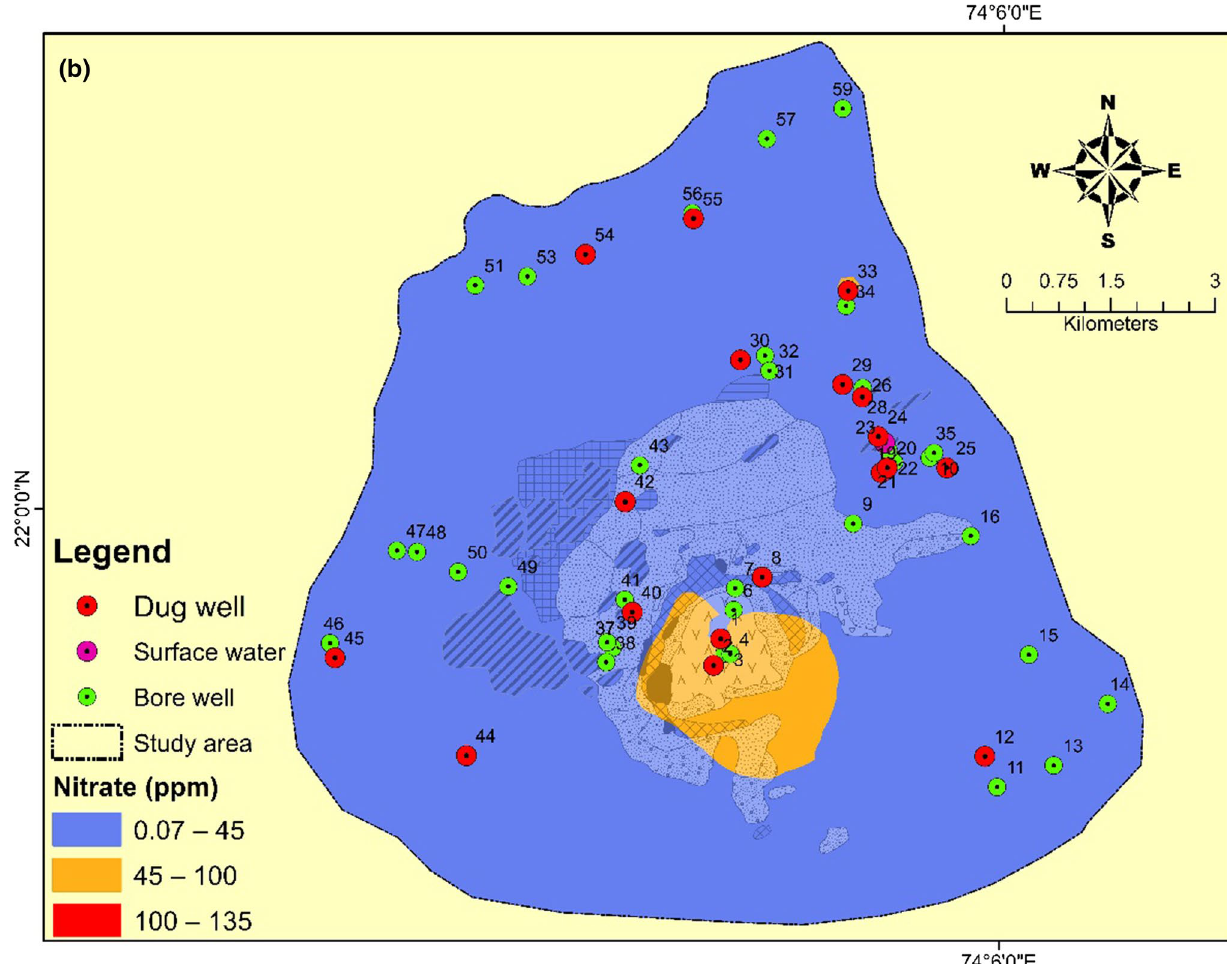
Piper plot: To categorise and differentiate the ground- water on the basis of its chemical composition the Piper’s trilinear diagram was used (Piper 1953) (Fig. 6a, b). This is helpful to know the total element character of waters in terms of cations and anions composition. The Piper’s plot for POM (Fig. 5a) shows that the Ca 2+ and HCO 3− as the main cations and anions, respectively. Most of the samples show cation Ca 2+ + Mg 2+ as dominant facies and HCO 3− as anion dominant facies in the post-monsoon season. Water type here shows dominance of Ca-HCO wherein about 68% 3 of the samples belong to this category, 19% of the samples show Mg-HCO type, 8% Ca–Cl type, 3% Mg–Cl type and 3 only 2% show Na-HCO 3− type. The pre-monsoon (Fig. 5b) samples show that the study area has Ca 2+ , Na + , Mg 2+ and HCO 3− as the predominant (72%), 21% of the samples show Na-HCO3 type of